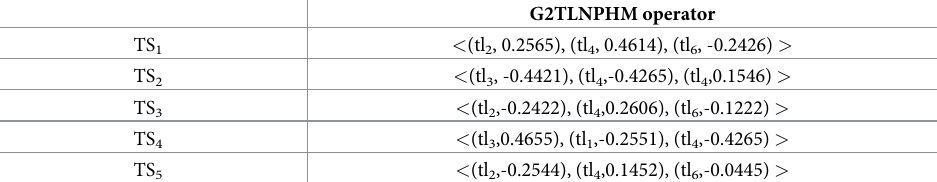
Table 2. The aggregating results by G2TLNPHM operator.